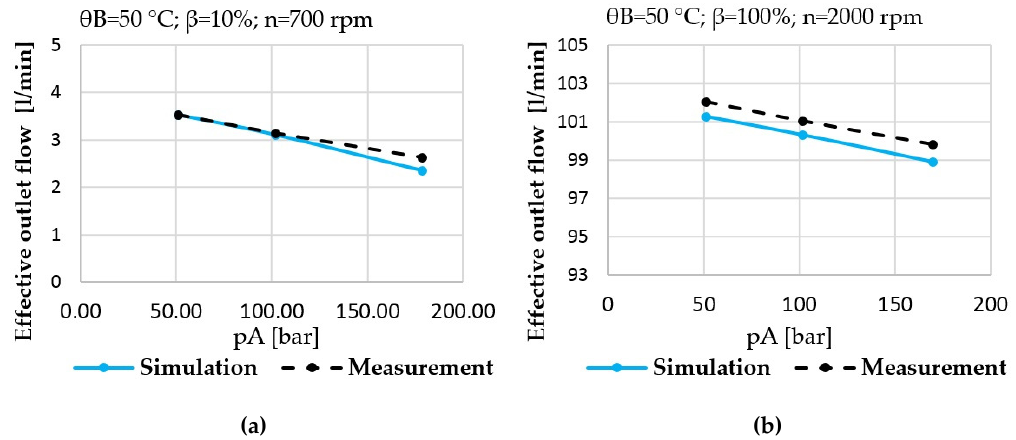
Figure 16. ( a ) Prediction vs. measurement; e ff ective outlet flow of the pump at low power Figure 16. (a) Prediction vs. measurement; effective outlet flow of the pump at low power operating condition; (b) prediction vs. measurement; effective outlet flow of the pump at high power operating operating condition; ( b ) prediction vs. measurement; e ff ective outlet flow of the pump at high condition. power operating